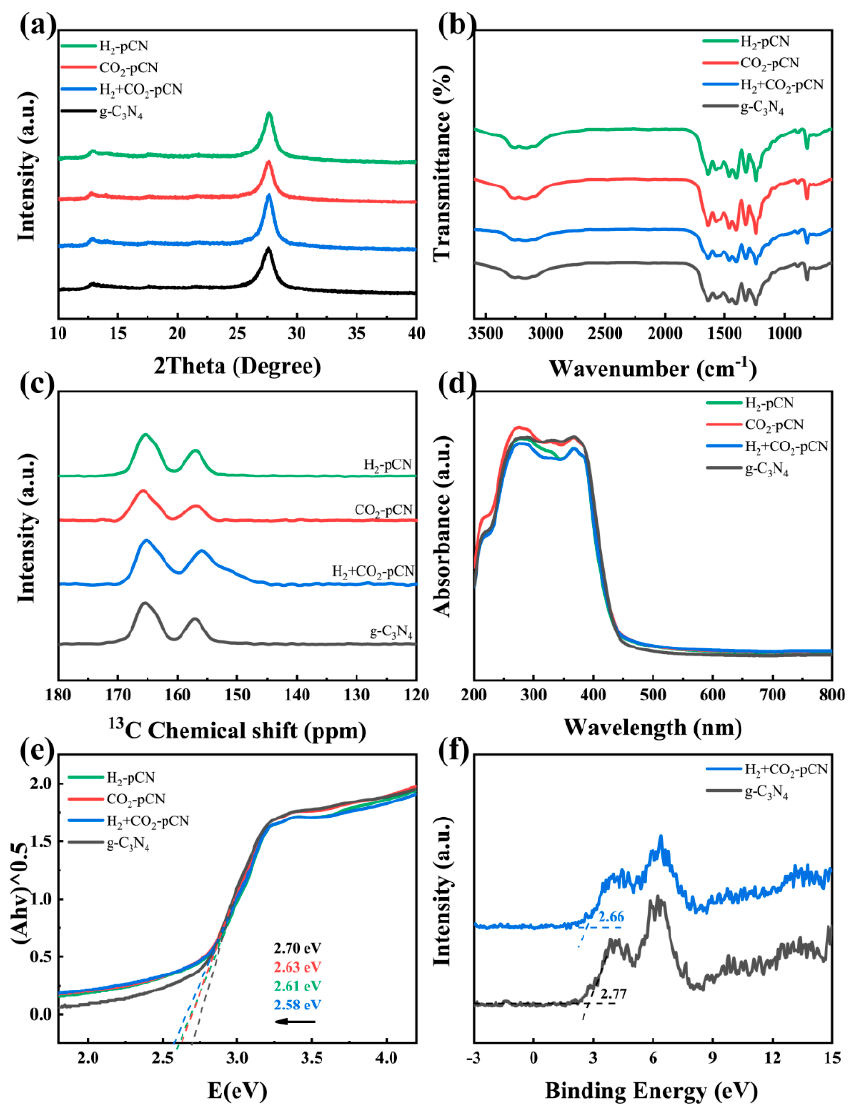
Figure 4. ( a ) XRD patterns, ( b ) FTIR spectra, ( c ) solid-state 13C MAS NMR spectra, ( d ) UV-vis DRS spectra and ( e ) transformed Kubelka–Munk function versus proton energy plots of raw g-C 3 N 4 , H 2 -pCN, CO 2 -pCN, and H 2 +CO 2 -pCN. ( f ) XPS valence band spectra of raw g-C 3 N 4 and H 2 +CO 2 -pCN.